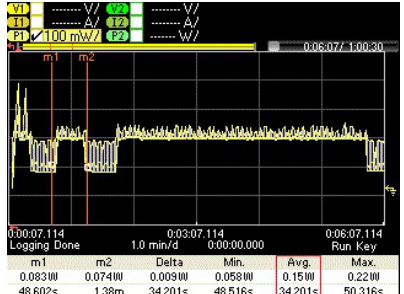
Figure 13. The energy consumed for transmitting an original image is ( a ) 0.012 Wh and for transmit- ting its optimized image it is ( b ) 0.0016 Wh, i.e., 84.3% energy